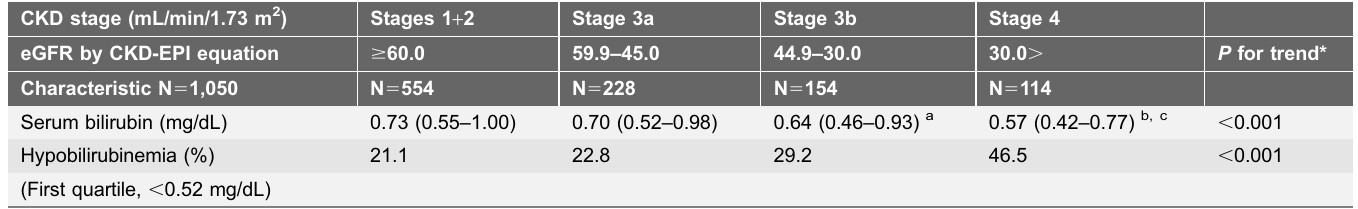
Table 2. Serum bilirubin and prevalence of hypobilirubinemia in the subjects by estimated glomerular filtration ratio. CKD stage (mL/min/1.73 m 2 ) Stages 1 + 2